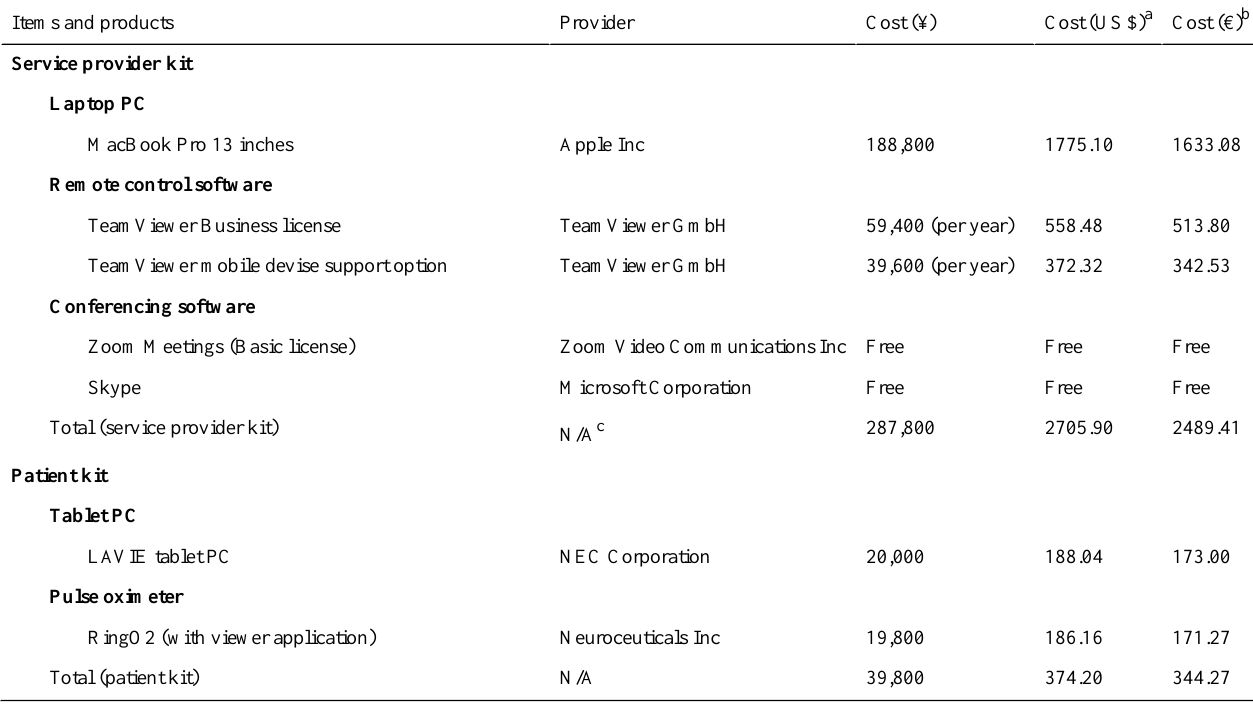
Table 1. Detailed initial costs for the devices and applications.